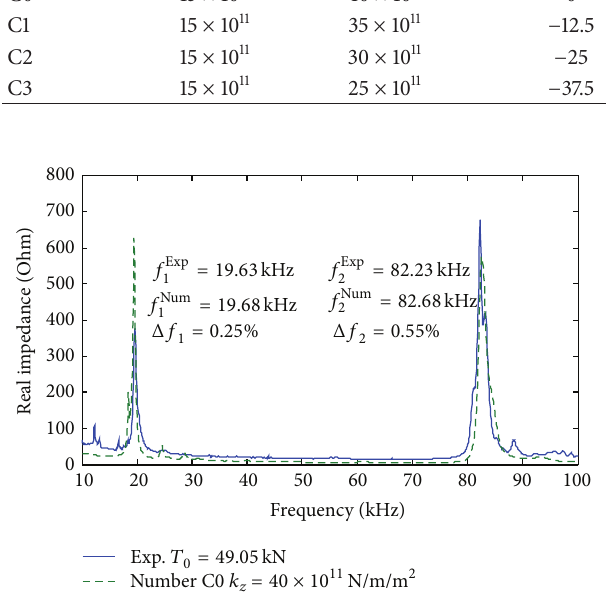
Figure 7: Numerical versus experimental impedance signatures.